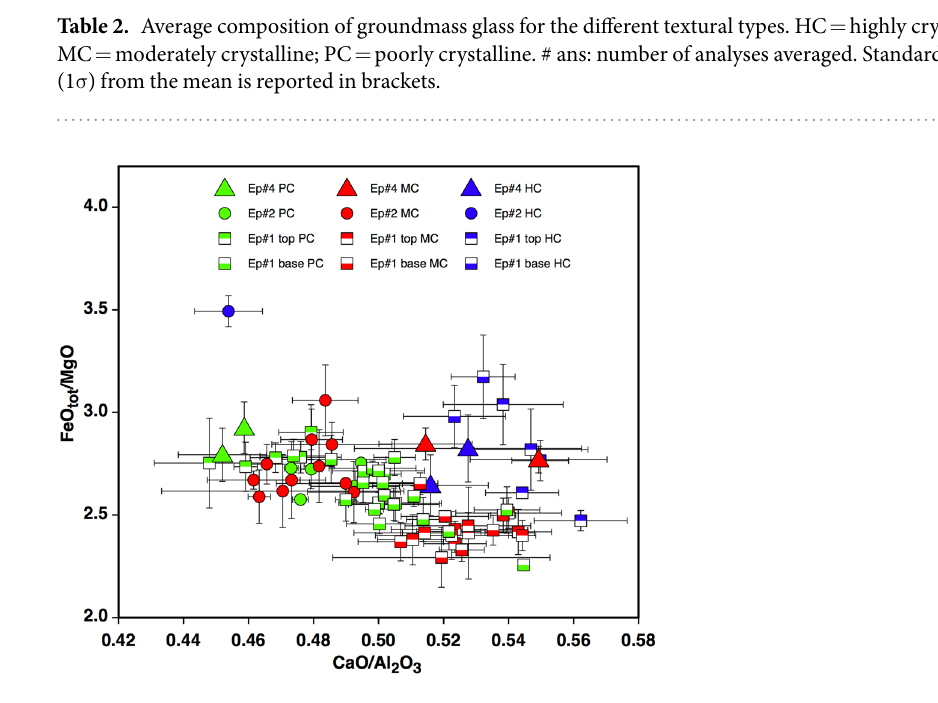
Figure 5. CaO/Al 2 O 3 vs FeO tot /MgO diagram reporting average (~2–5 analyses per clast) groundmass compositions for clasts of differing crystallinity (HC = highly crystalline = blue symbols, MC = moderately crystalline = red symbols; PC = poorly crystalline = green symbols) from distinct eruptive episodes. Error bars show standard deviation from the average (1 σ